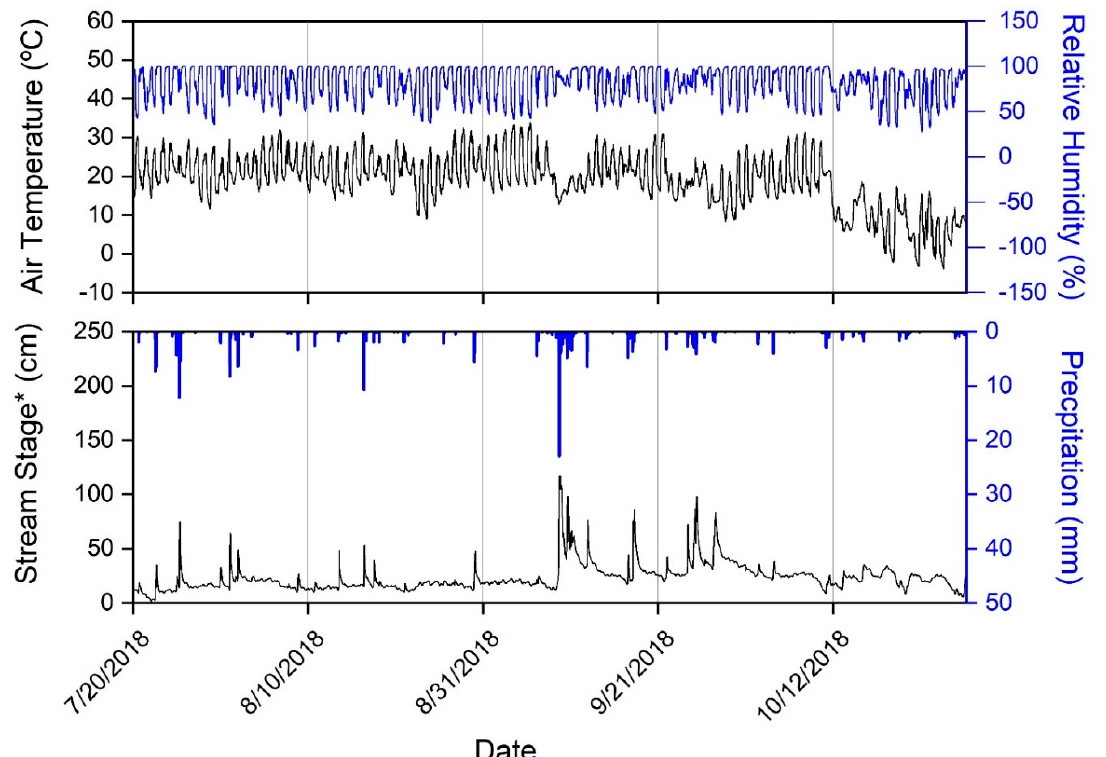
Figure 2. Thirty-minute time series of climate variables (recorded at the climate station) during study period (20 July 2018–27 October 2018) in West Run Watershed, West Virginia, USA. * Note: Stream stage was monitored in the primary stream of WRW, West Run Creek, within approximately 100m of the confluence of Site #1 and West Run Creek (39°40 ′ 3.20 ′′ N 79°55 ′ 48.99 ′′ W).